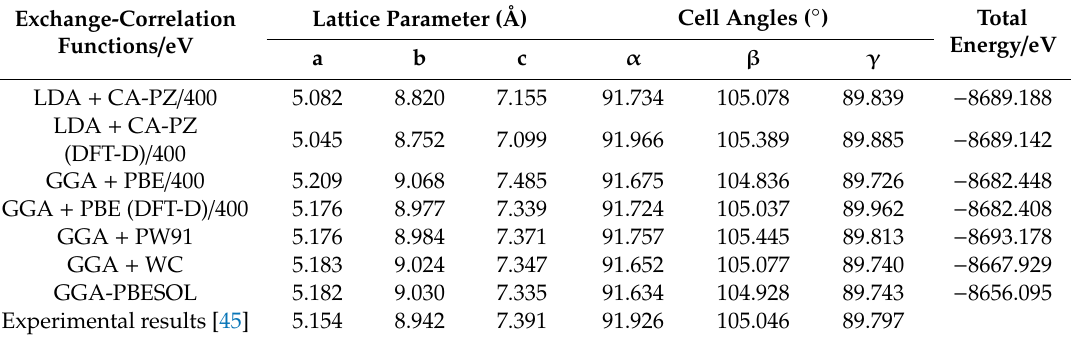
Table 1. Optimized results of the bulk of kaolinite.